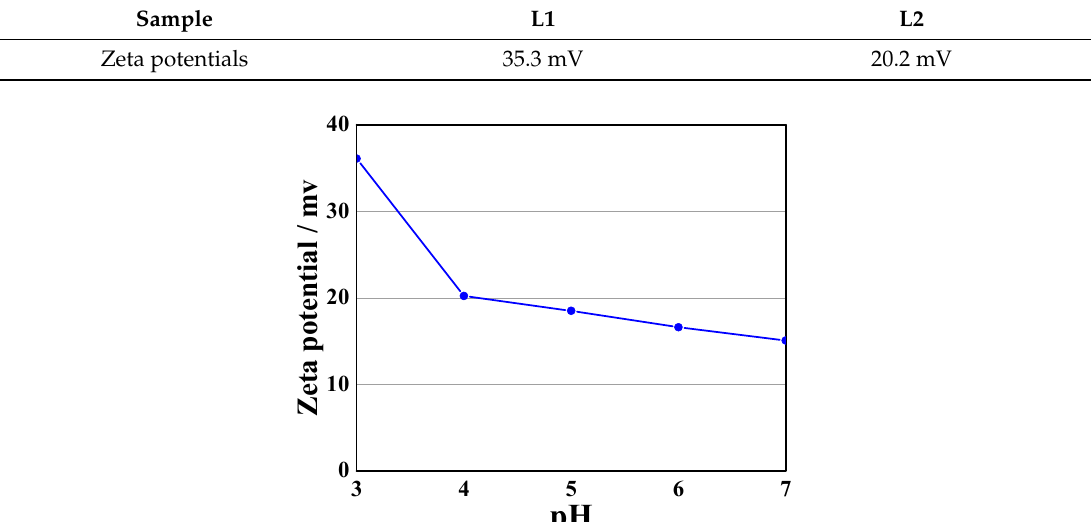
Table 3. Zeta potentials of the sample (L1 and L2) dispersed in aqueous solution at pH 4.